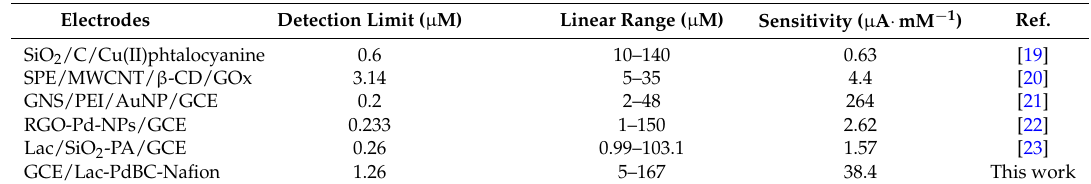
Figure 8. Selectivity of the GCE/Lac-PdBC-Nafion in pH 7.0 PBS containing different interferents.